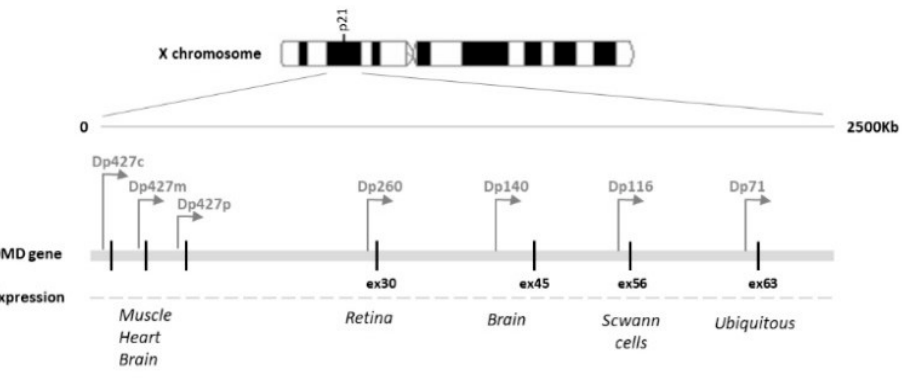
Figure 1. Schematic representation of the dystrophin gene and isoforms [5].